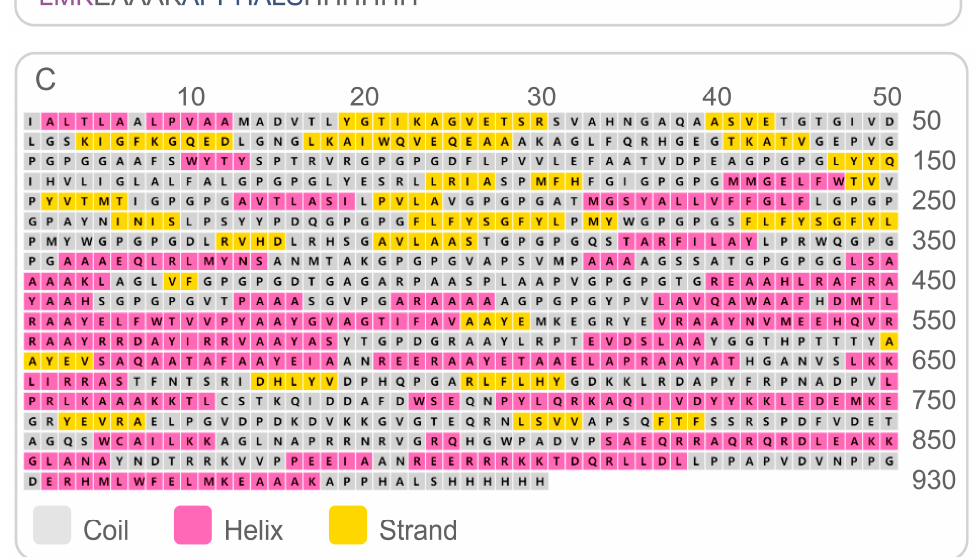
Figure 1. Schematic diagram of the PP19128R vaccine construction strategy and secondary structure. ( A ) The PP19128R vaccine was constructed based on TLR2 agonist PorB, pan HLA DR-binding epitope PADRE, 19 HTL epitopes, 12 CTL epitopes, 8 B-cell epitopes, and TLR-4 agonist RS-09. ( B ) The amino acid sequence of the PP19128R vaccine, with different elements indicated by different colors. ( C ) The coil, helix, and strand secondary structures in the amino acid sequence of the PP19128R vaccine are shown in gray, pink, and yellow, respectively.